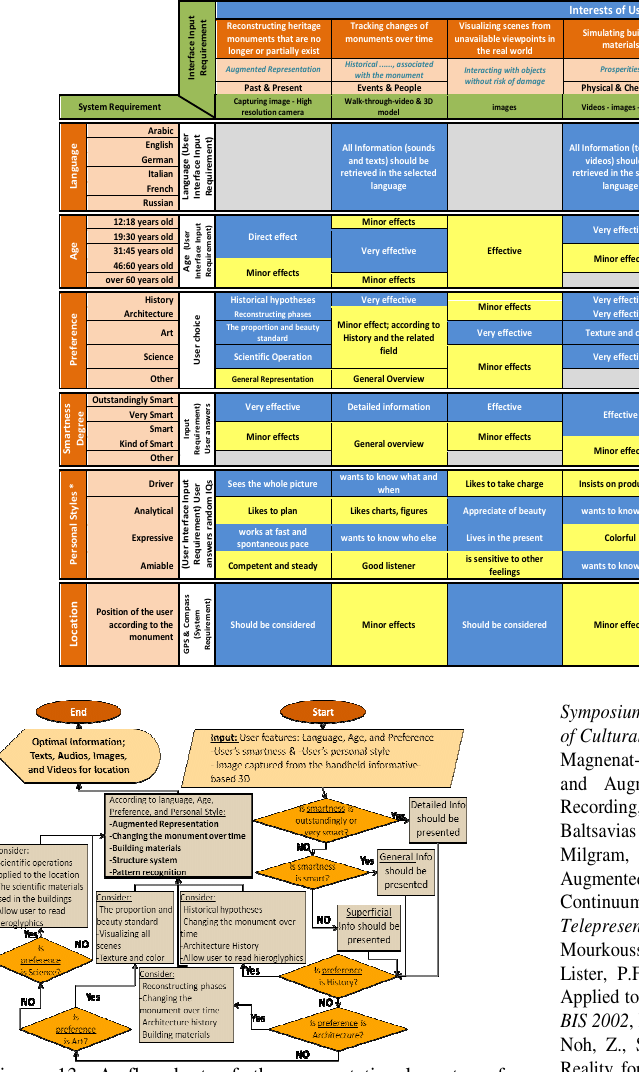
Table 1. A Matrix of thorough analysis of the relationship between users’ features and interests in cultural heritage